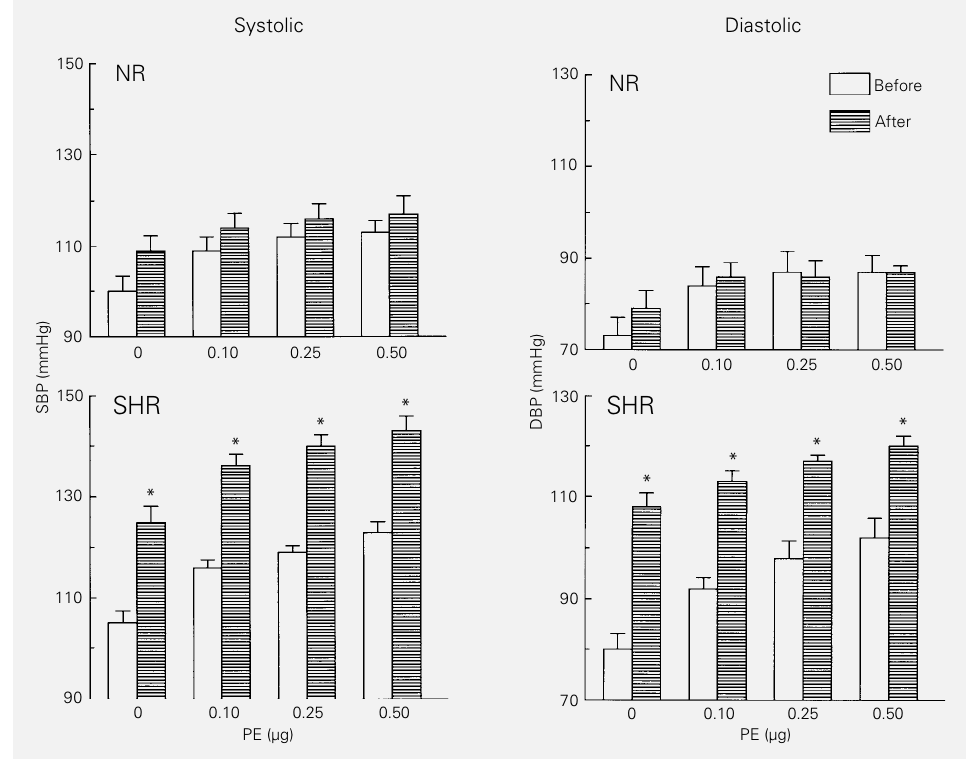
Figure 6 - Effects of increasing Diastolic doses of phenylephrine (PE) on the systolic blood pressure (SBP) and diastolic blood pres- Before sure (DBP) of normotensive (NR) and hypertensive (SHR) rats be- fore and after 1-h treatment with 0.18 (cid:181)g/kg ouabain. Column height indicates the mean and the bar the SEM. *P<0.05 for comparison between before and after ouabain treatment (ANOVA).